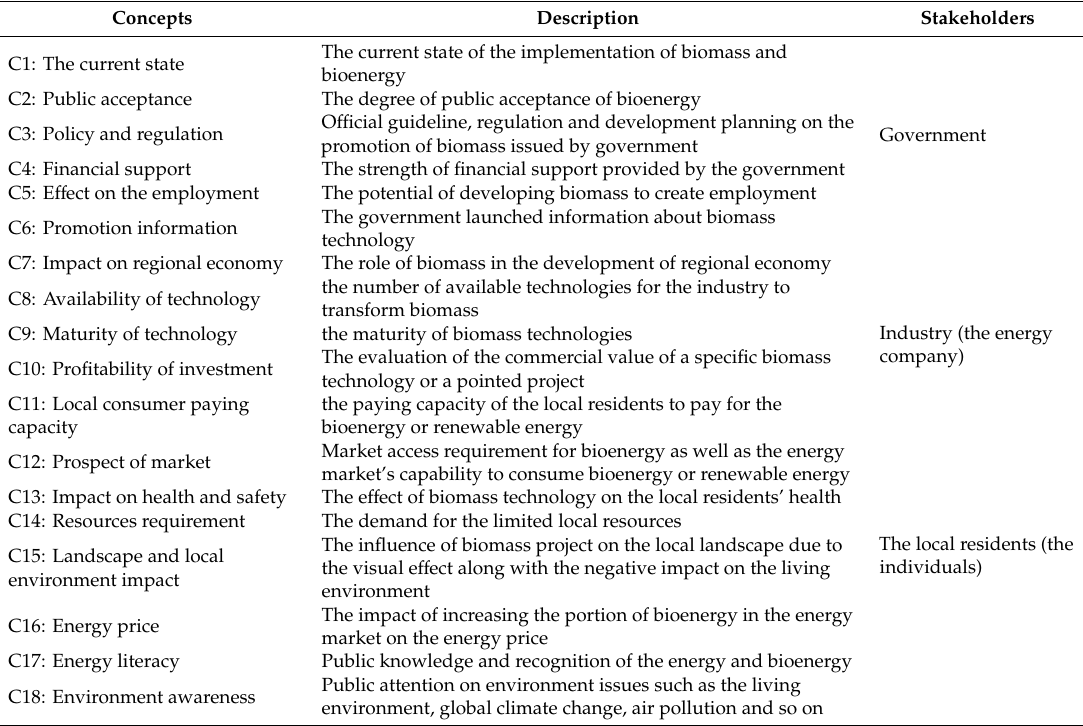
Table 2. All the factors in